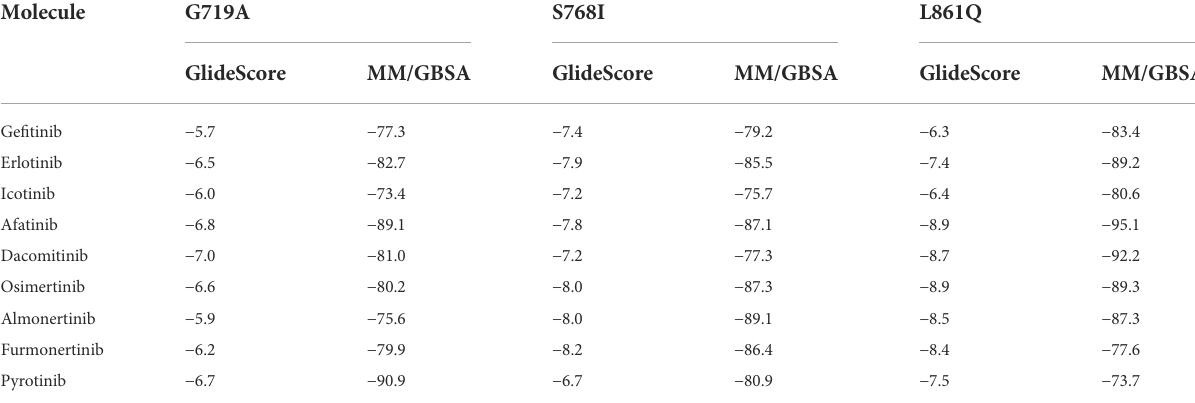
TABLE 5 Binding free energies ( Δ Gbind, kcal/mol) of different TKIs for EGFR major uncommon mutations by dynamics calculation. Molecule G719A